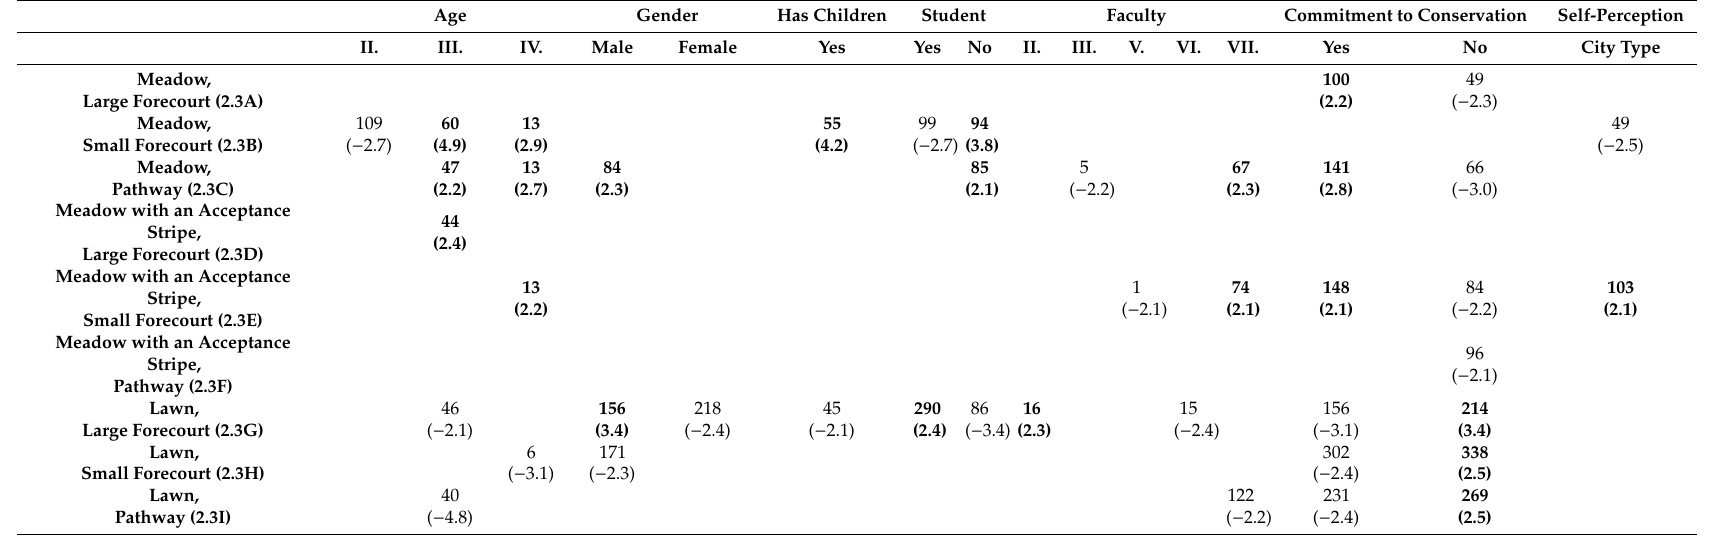
Table 5. Question 2.3 compared natural late summer meadows (2.3A, 2.3B, 2.3C, 2.3D, 2.3E, and 2.3F) with lawns (2.3G, 2.3H, and 2.3I). The meadows were illustrated with (2.3D, 2.3E, and 2.3F) and without (2.3A, 2.3B, and 2.3C) an acceptance stripe. All green spaces were presented with variation in the degree of overgrowth: